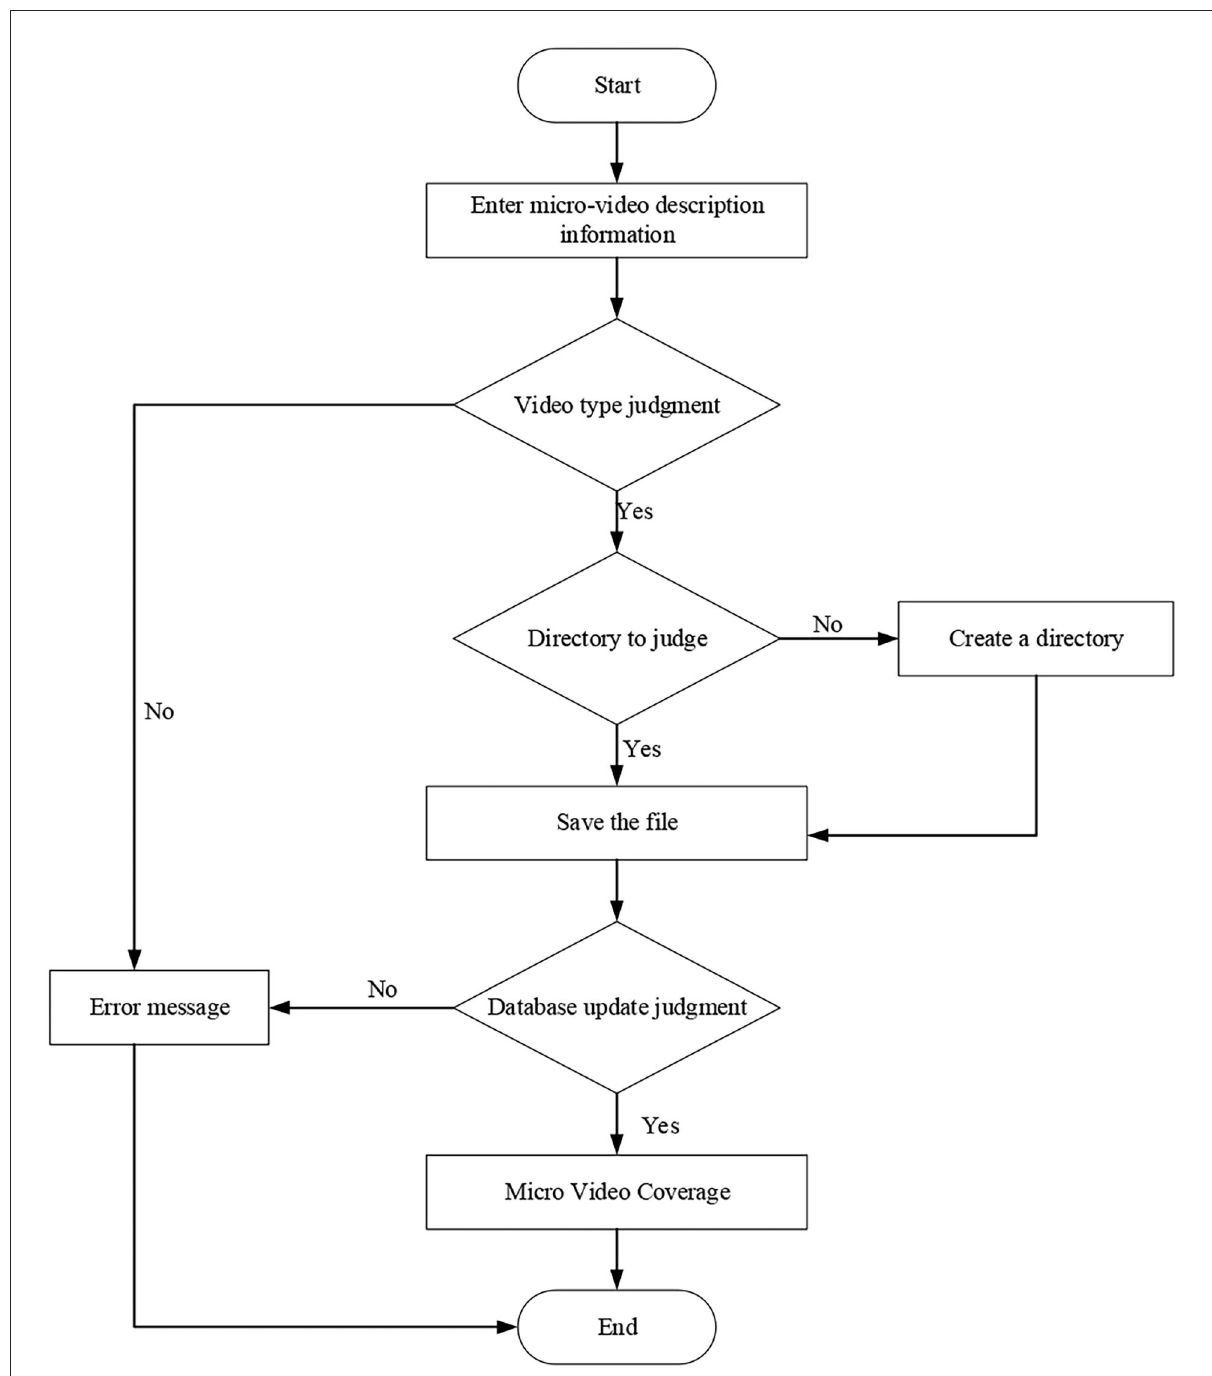
FIGURE9 Micro-video upload